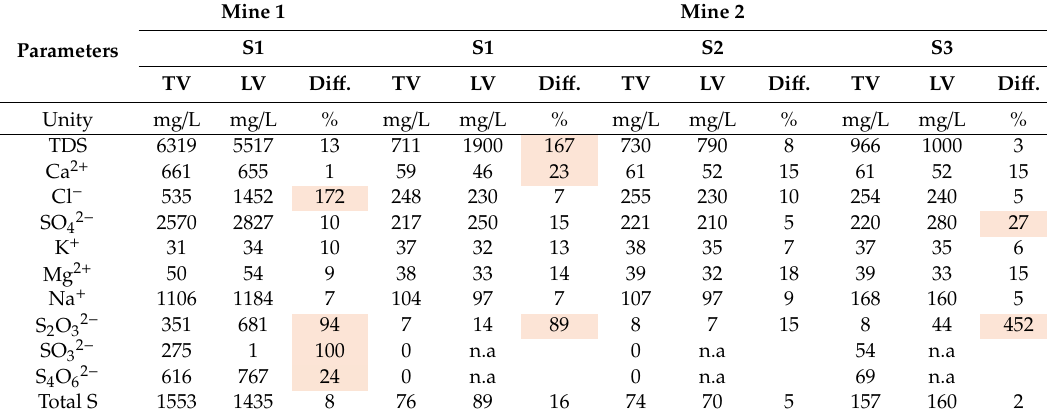
Table 5. Theoretical values and analysis results of the control samples (the analysis where the difference is significant is highlighted in red).